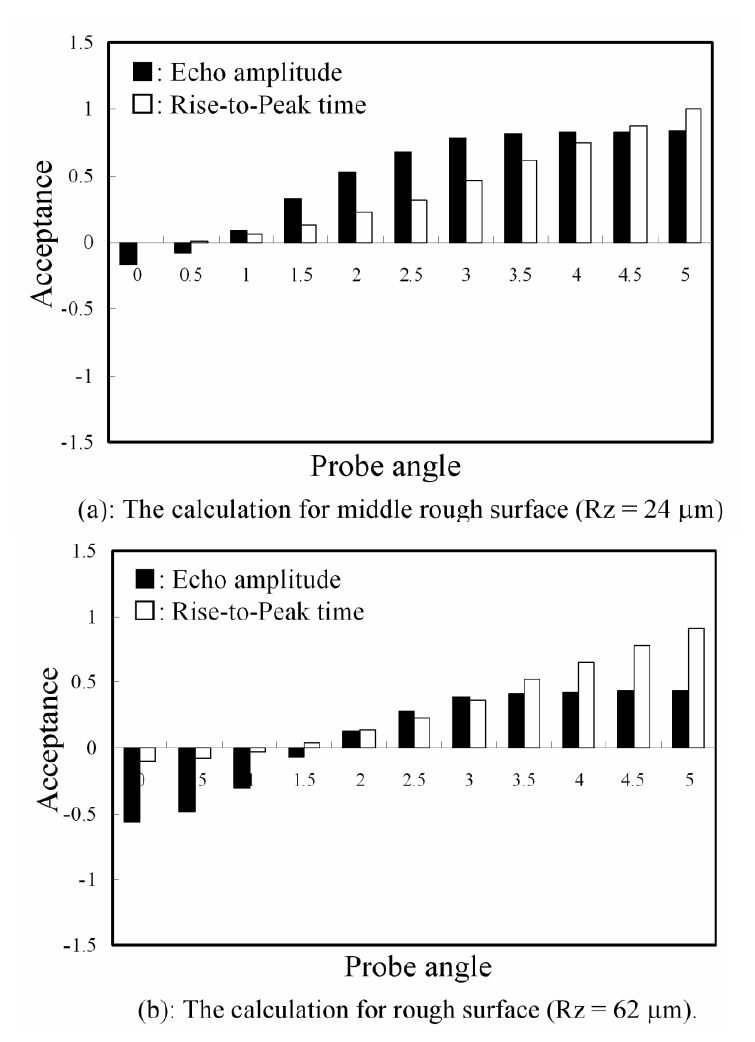
Figure 6: The Acceptance of echo amplitude and Rise-to-Peak time calculated from equation (1). (a): The calculation for the middle rough surface (Rz = 24 µ m). (b): The calculation for the rough surface (Rz = 62 µ